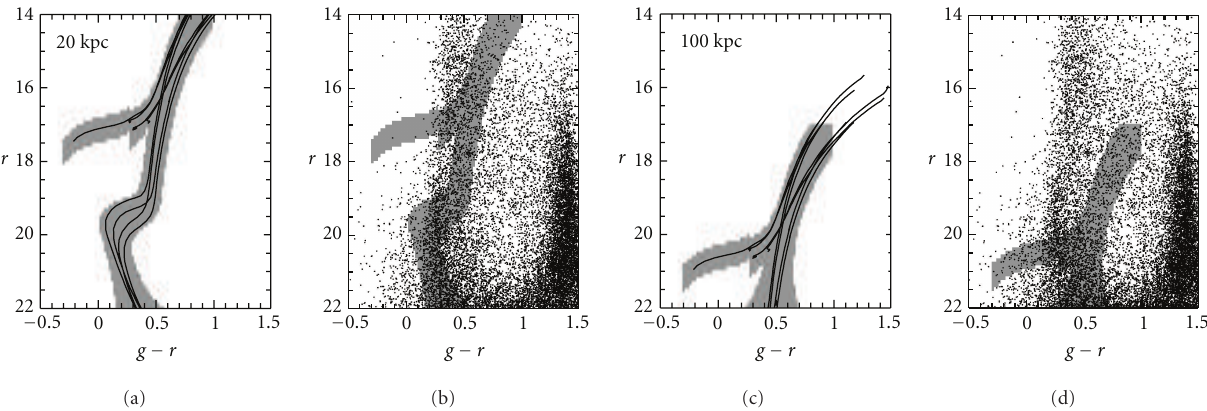
Figure 1: A color-magnitude (CM) filter used to suppress the noise from foreground stars while preserving the signal from dwarf galaxy stars at a specific distance. (a) and (c) CM filters for an old and metal-poor stellar population at a distance modulus of 16.5 and 20.0, respectively. The solid lines show Girardi isochrones for 8 and 14Gyr populations with [Fe / H] = − 1 . 5 and − 2 . 3. (b) and (d) These CM filters overplotted on stars from a 1deg 2 field to illustrate the character of the foreground contamination as a function of dwarf distance. Data are from SDSS DR7.